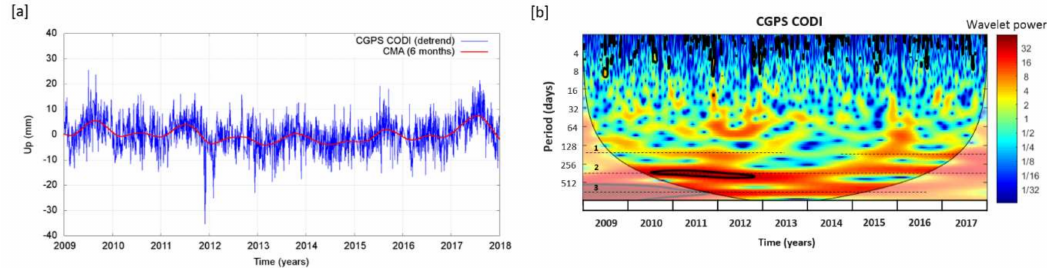
Figure 5. Time and time-frequency analysis of CODI CGPS time series: ( a ) residual (original data detrended by the linear trend; blue line) and 6-month smoothed CMA fitting (red line); ( b ) continuous wavelet power spectrum (colored map) and main power peaks (dashed black lines): 1, 2, and 3 represent power peaks at periods of 190-day (~6 months), 365-day (1 year), and 770-days scales (~2.1 years),